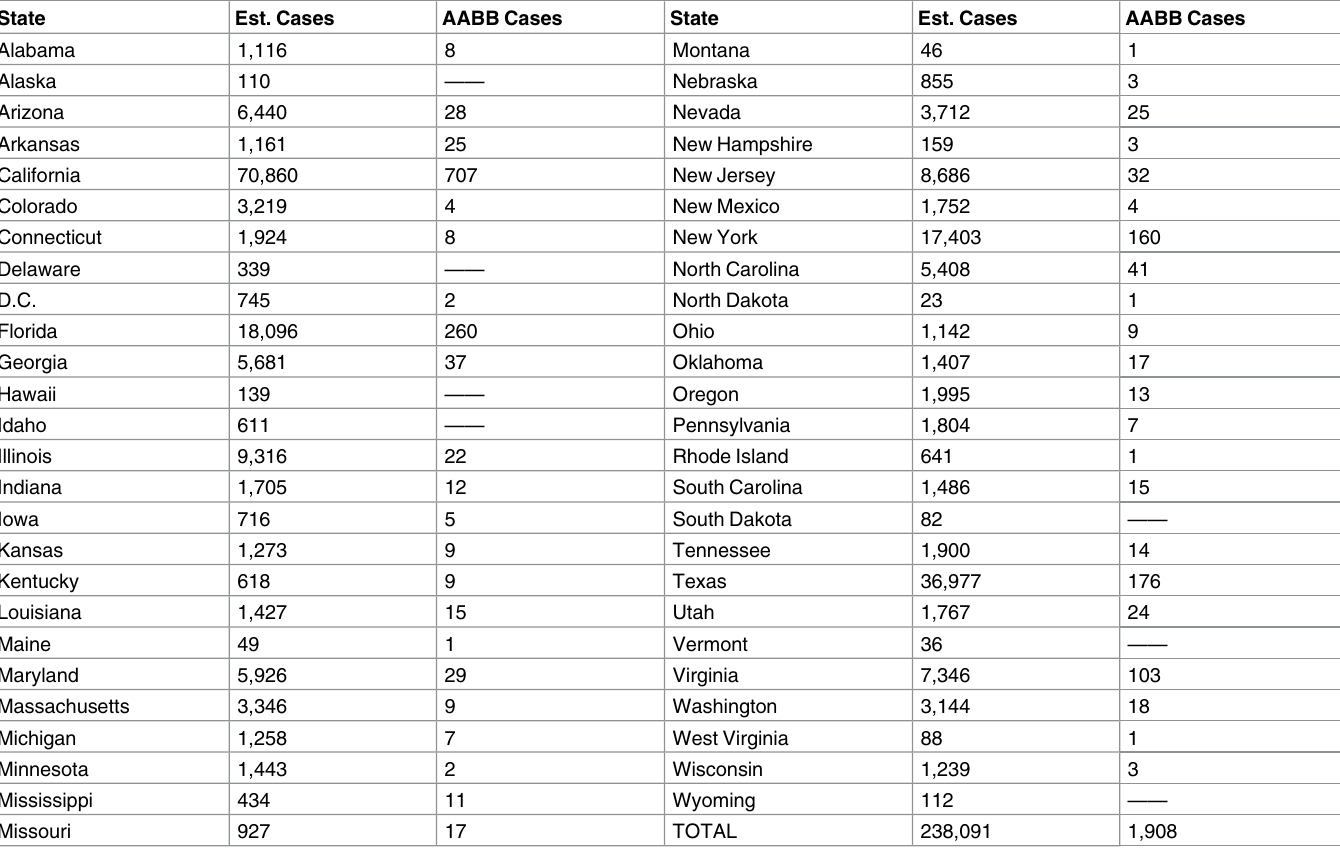
Table 1. Estimated T . cruzi cases in the United States in 2012 and confirmed cases of T . cruzi infection in donated blood per AABB from 2007– 2013, by